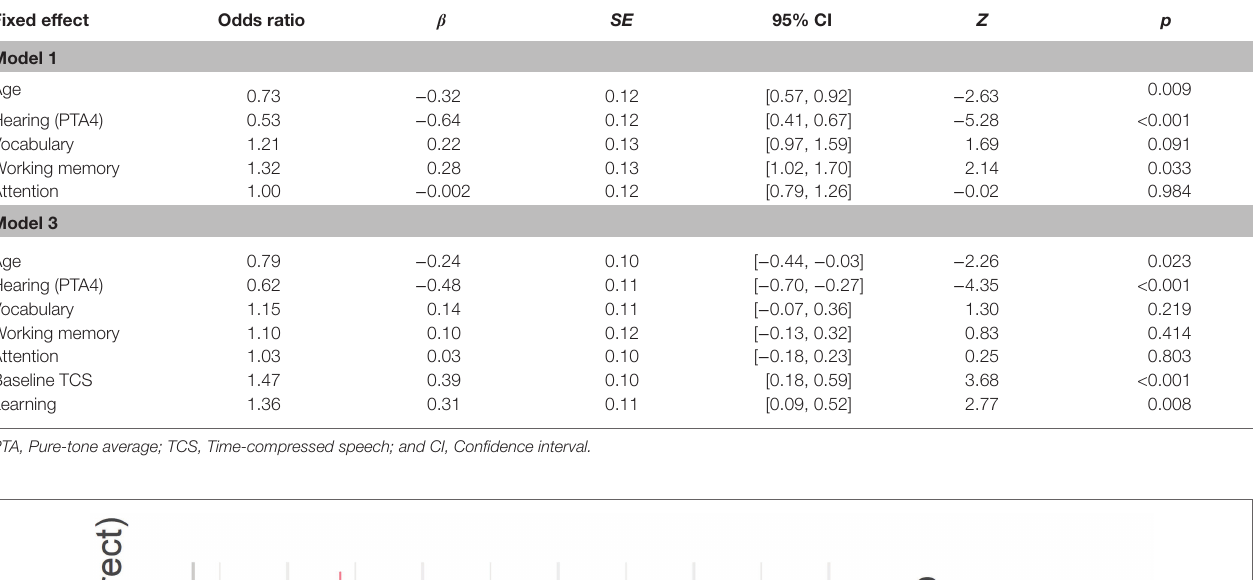
TABLE 5 | Results of generalized linear mixed-model for fast speech recognition as a function of the background variables (Model 1) and as a function of age, hearing, cognition, baseline recognition of time-compressed speech, and rapid perceptual learning as fixed effects (Model 3). Fixed effect